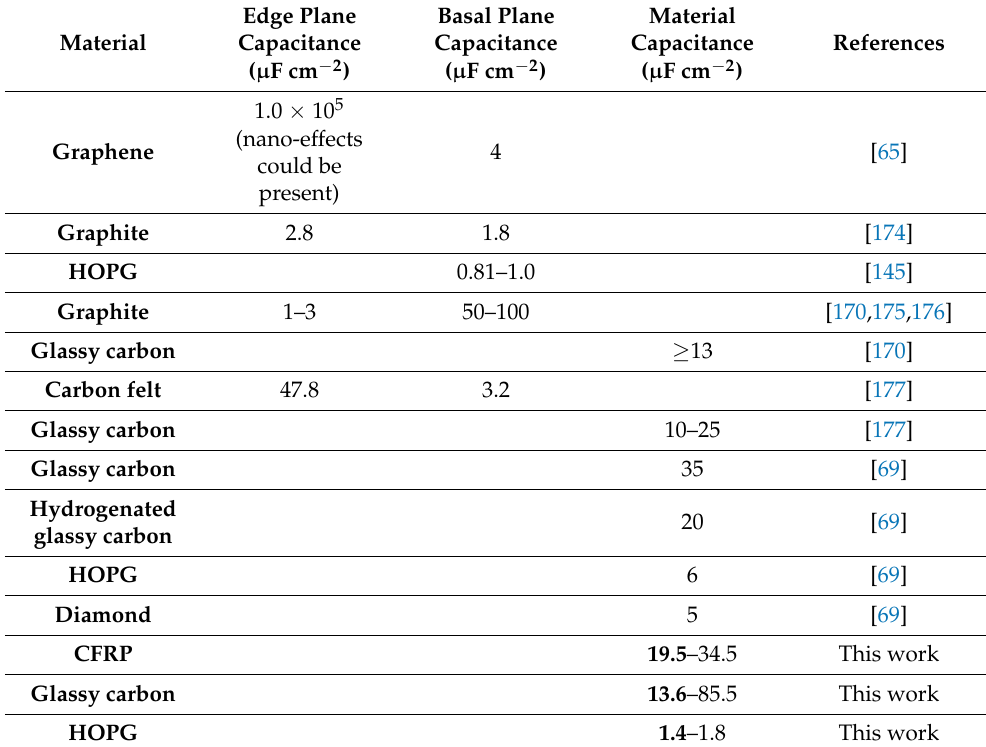
Table 2. Reported capacitance values for different carbon surfaces and